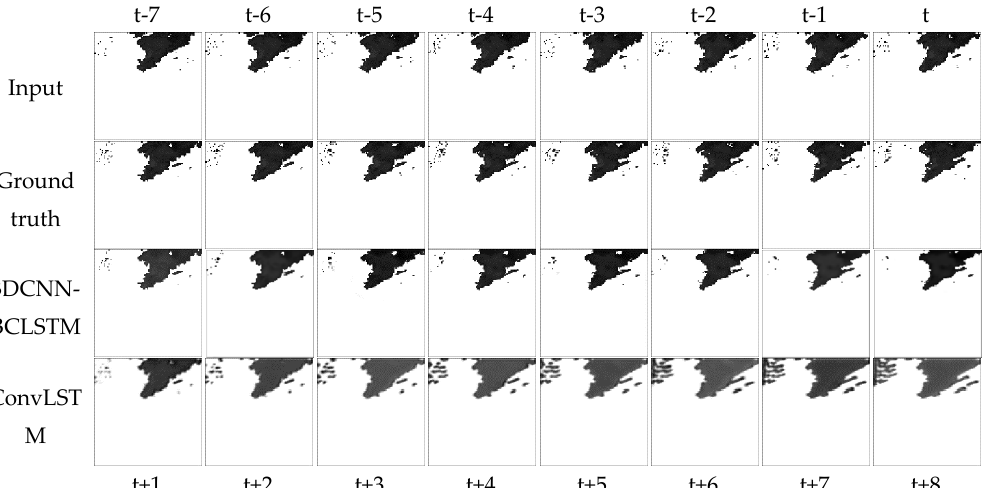
Figure 7. The prediction example of advection motion for radar echo nowcasting at 15:06 UTC on 16 July 2015. From top to bottom: input, ground truth, prediction of 3DCNN ‐ BCLSTM model, and prediction of the ConvLSTM model.